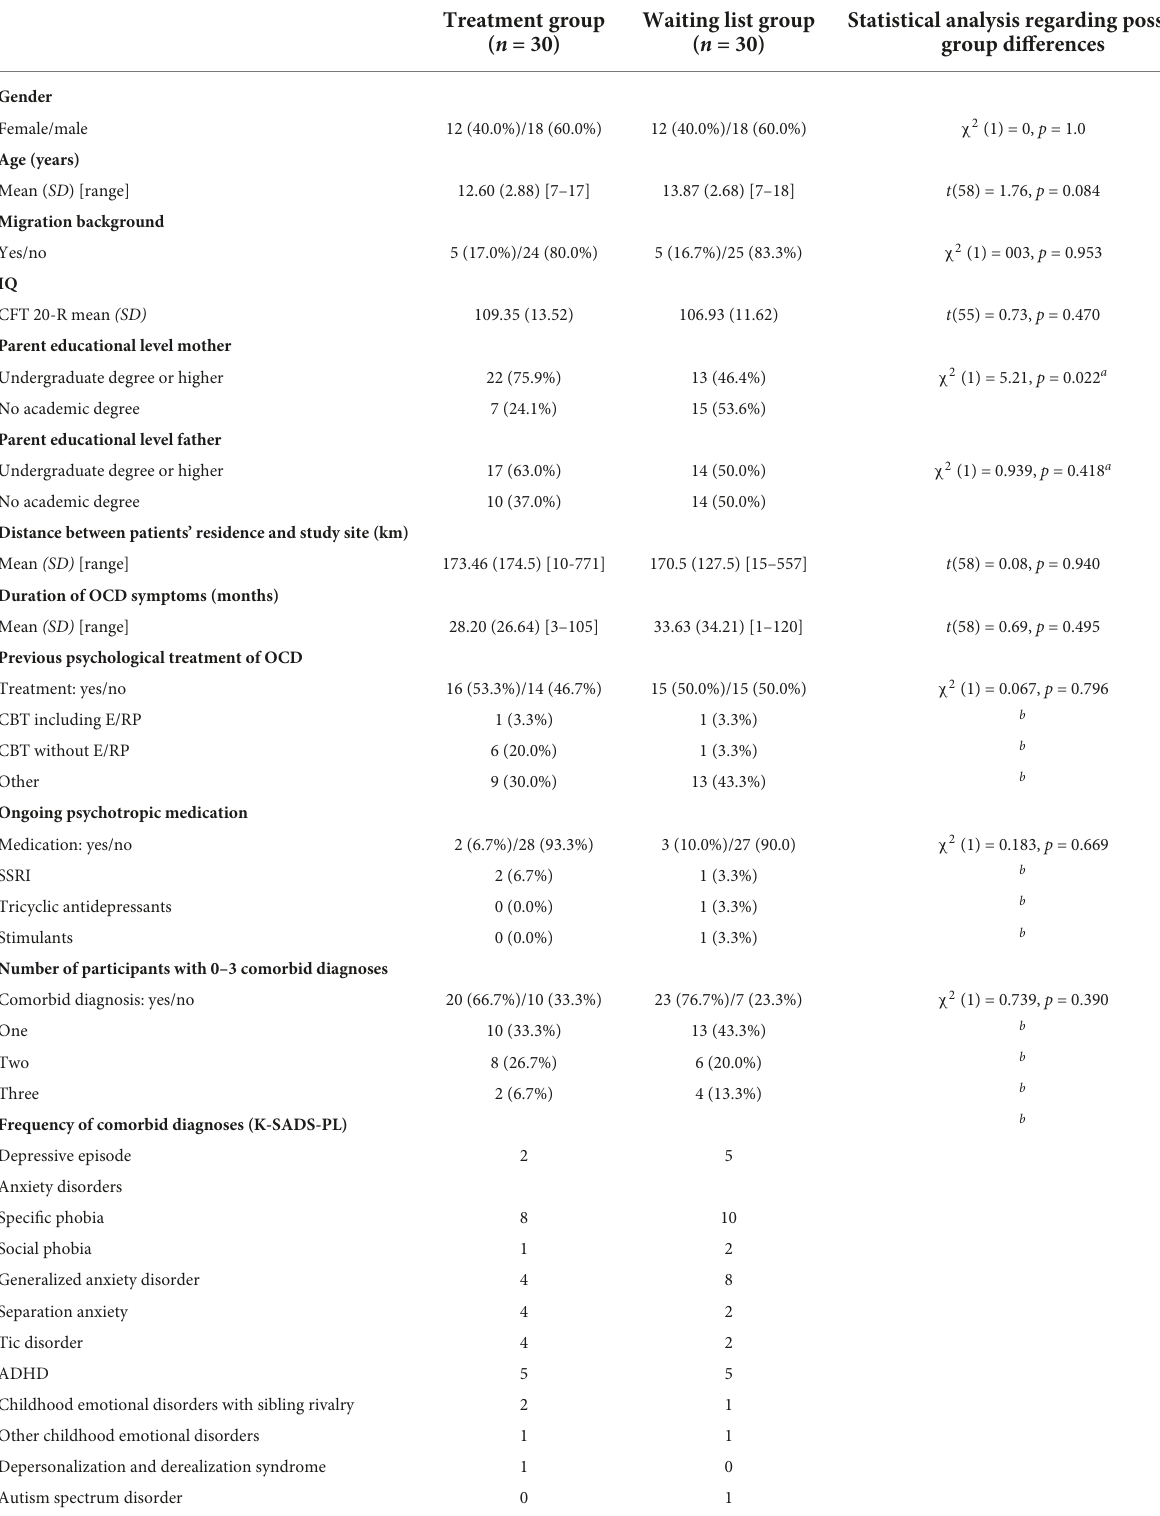
TABLE 1 Sociodemographic and clinical characteristics of participants at baseline ( N =